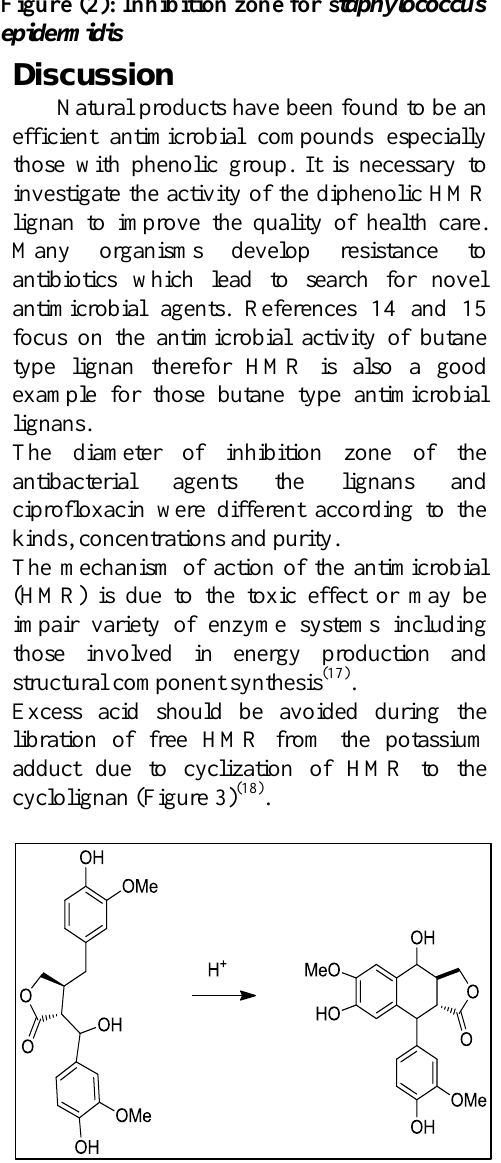
Figure (3): Cyclization of HMR to cyclolig- nansin acidic